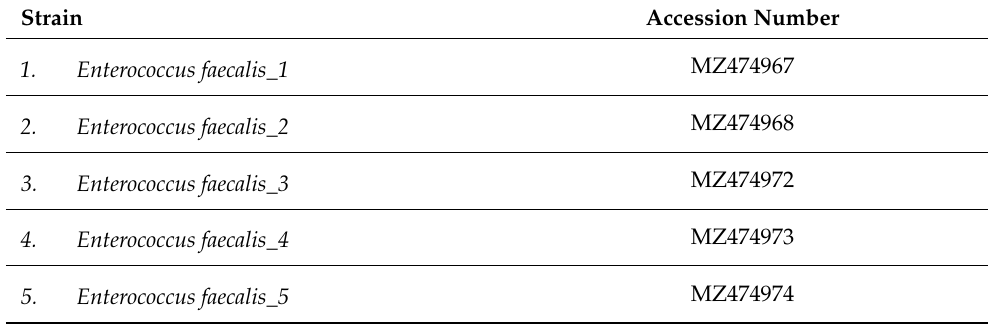
Table 4. Accession numbers provided by GenBank database of all strains DNA